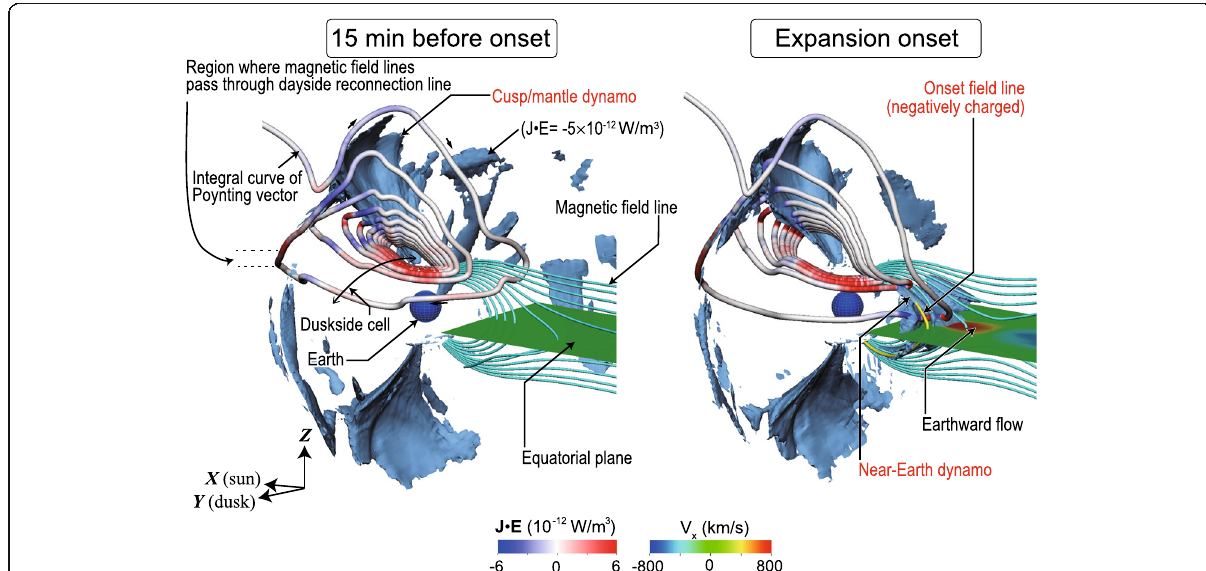
Fig. 15 The principal pathway of electromagnetic energy in the magnetosphere (as shown by the white line) at 15 min before onset (left panel) and at expansion onset (right panel). The blue shade indicates the region where J (cid:129) E < 0 (dynamo region). The light blue line indicates the magnetic field line. The plane indicates the equatorial plane with color given by the X -component of the plasma flow. The yellow line stands for the magnetic field line extending from the onset location in the ionosphere. (Adapted from Ebihara and Tanaka